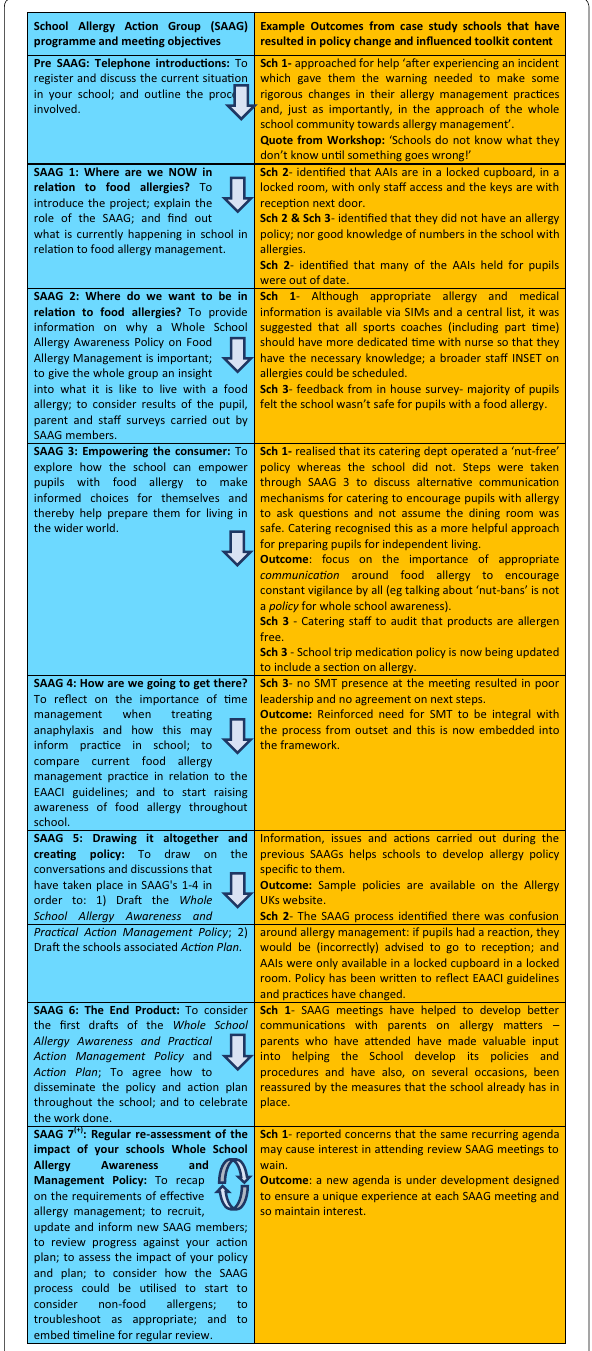
Fig. 1 Whole school allergy awareness process stages with